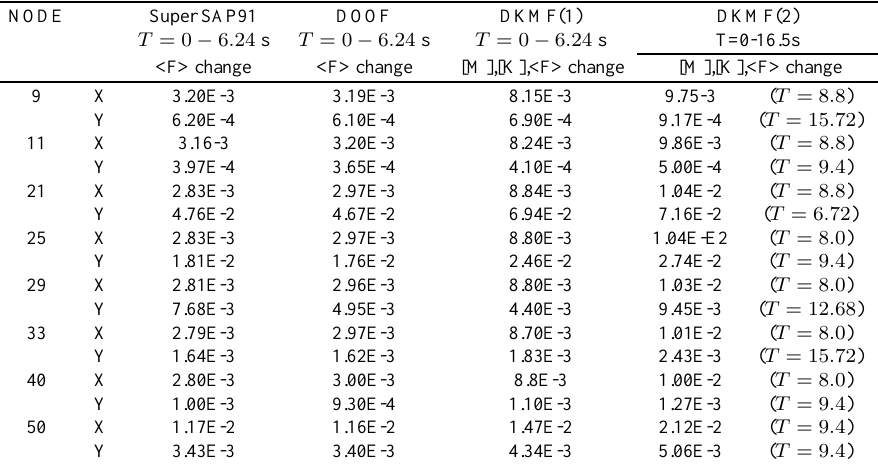
Fig. 10. Node 50 vibration. Table 1 Displacement (m) comparison of key